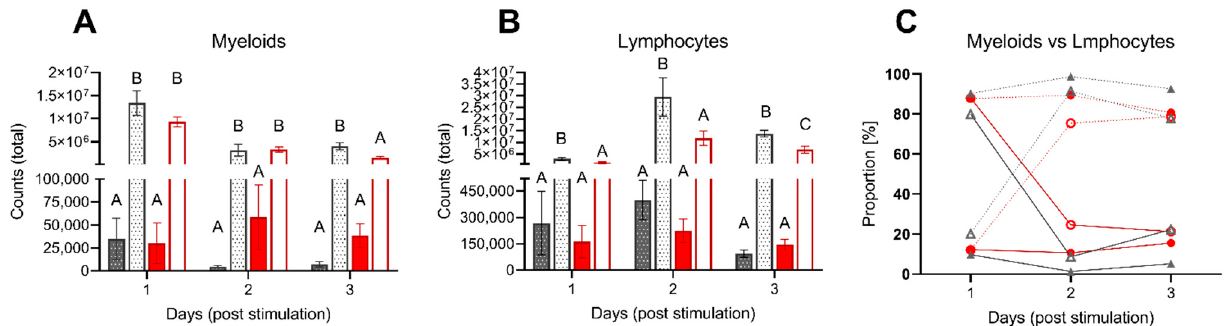
Figure 6. Kinetics of peritoneal leukocytes upon acute peritoneal inflammation. Total counts of myeloid cells ( A ), lym- phocytes ( B ) and proportion of both cell types ( C ) after one, two and three days post intraperitoneal stimulation with inactivated Aeromonas hydrophila cells. Graphs A and B show differences between normoxic control groups, either unstimu- lated (dark grey/patterned) or stimulated (bright grey/patterned), and low DO groups, either unstimulated (dark red) or stimulated (bright red). Columns represent mean of four individual samples (+SEM). Statistical significance per each day was determined using the one-way ANOVA followed by Tukey’s multiple comparison test ( p = 0.05); different letters (A–C) represent significant changes between different groups. Graph C shows differences between control groups, either unstimulated (grey, filled triangle) or stimulated (grey, open triangles), and the low DO groups, either unstimulated (red, filled circles) or stimulated (red, open circles). Dotted lines represent lymphocytes, filled lines represent myeloid